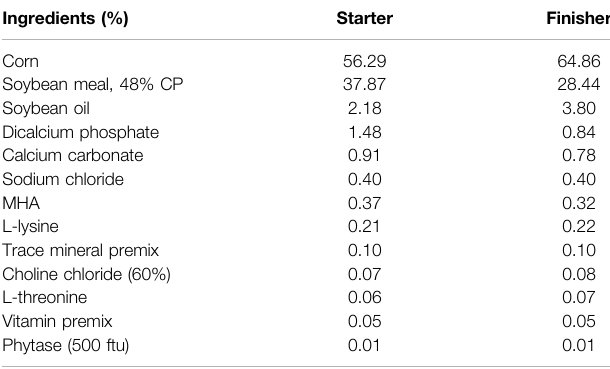
TABLE 1 | Ingredient and nutrient composition of basal diets (as-fed